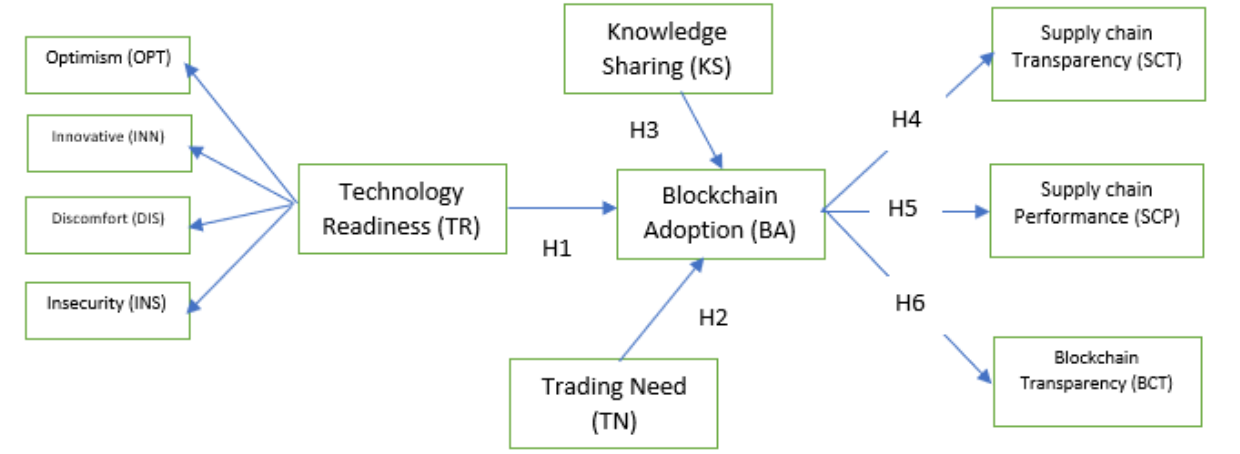
Figure 1. Research model and hypothesis